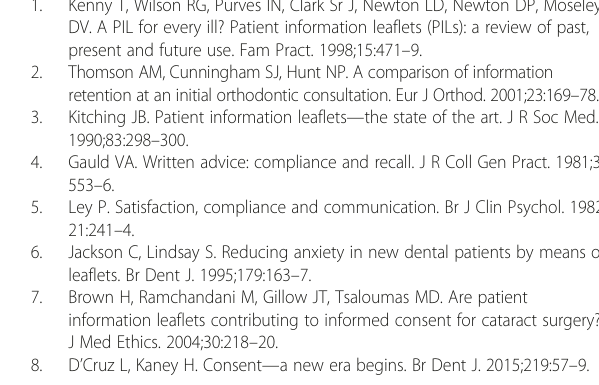
Table 5 Univariate median regression-derived coefficients ( β ) and 95 % confidence intervals (CI) for readability scores as dependent variables for the 36